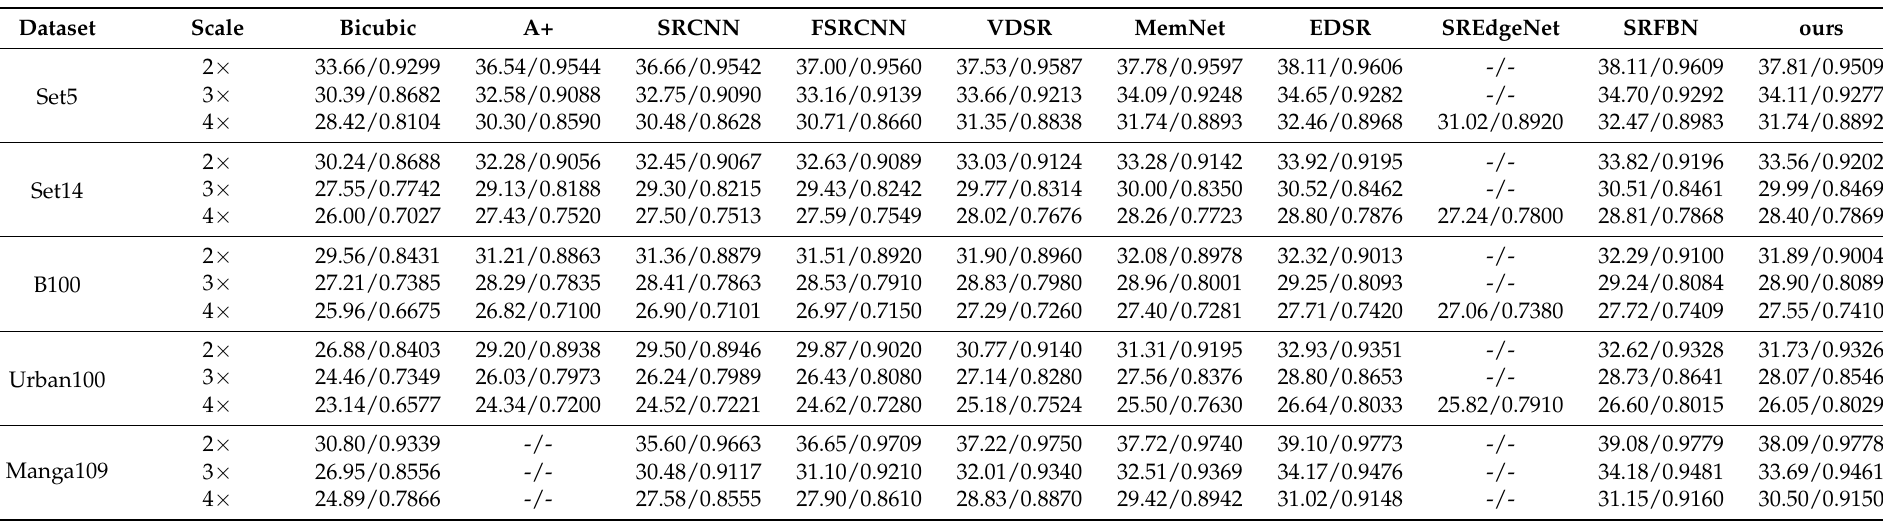
Table 4. Quantitative results of state-of-the-art single image super-resolution (SISR) methods. The average results of PSNR/structural similarity (SSIM) with 2 × , 3 × , and 4 × on datasets Set5, Set14, B100, Urban100, and